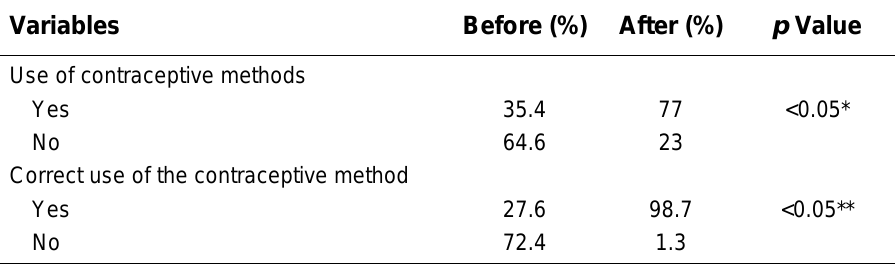
Relationship Between Contraceptive Methods Used by Adolescents Before and After ISPPT Variables Before (%) After (%) p Value Use of contraceptive